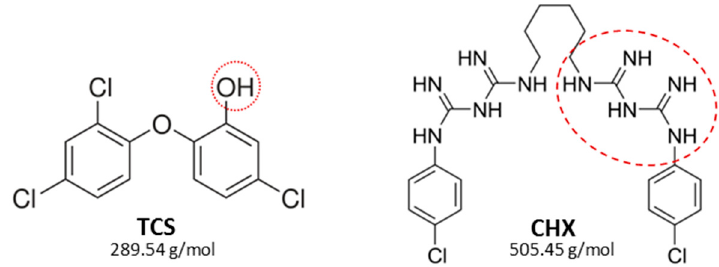
Scheme 1. Chemical formulas of the selected antibacterial drugs. Dashed red circles point out distinctive functional.